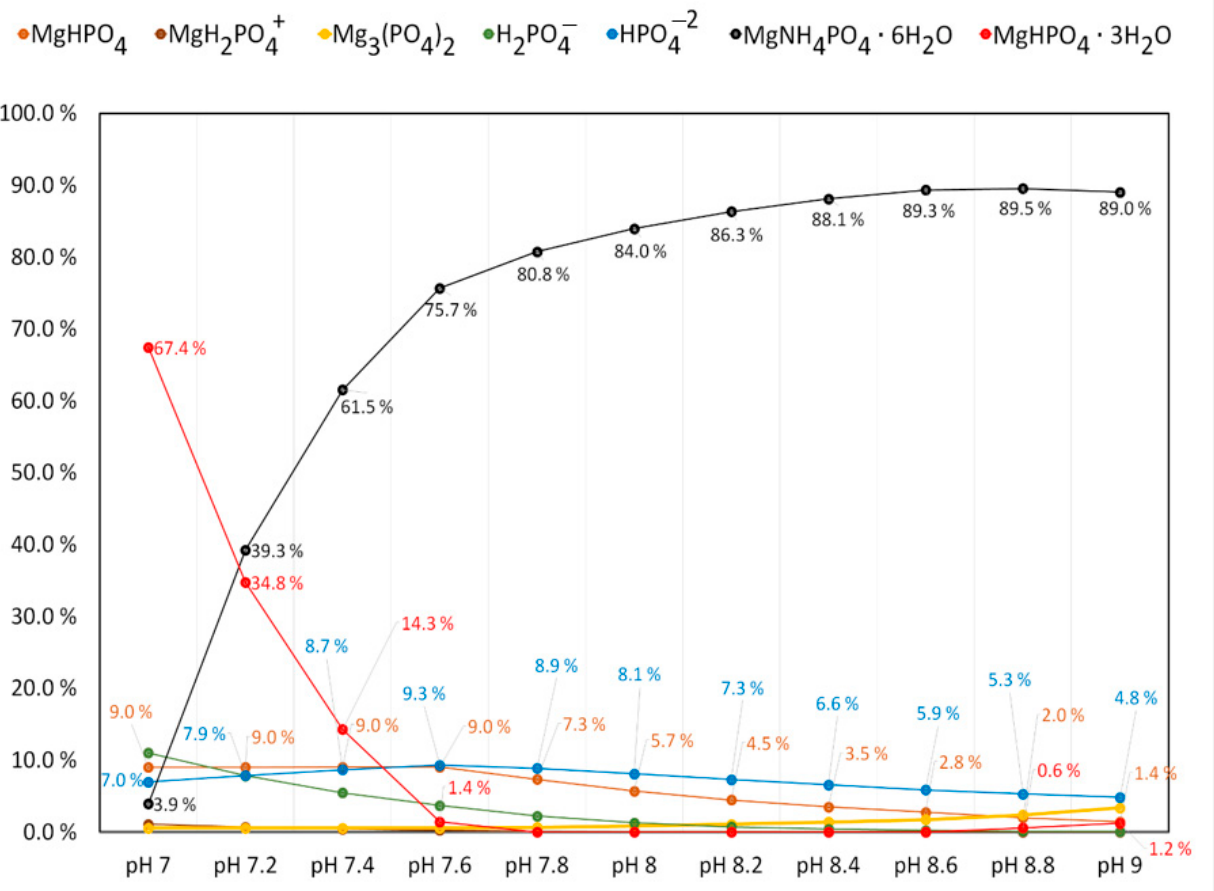
Figure 2. Phosphate speciation as a function of pH as determined by the MINEQL+